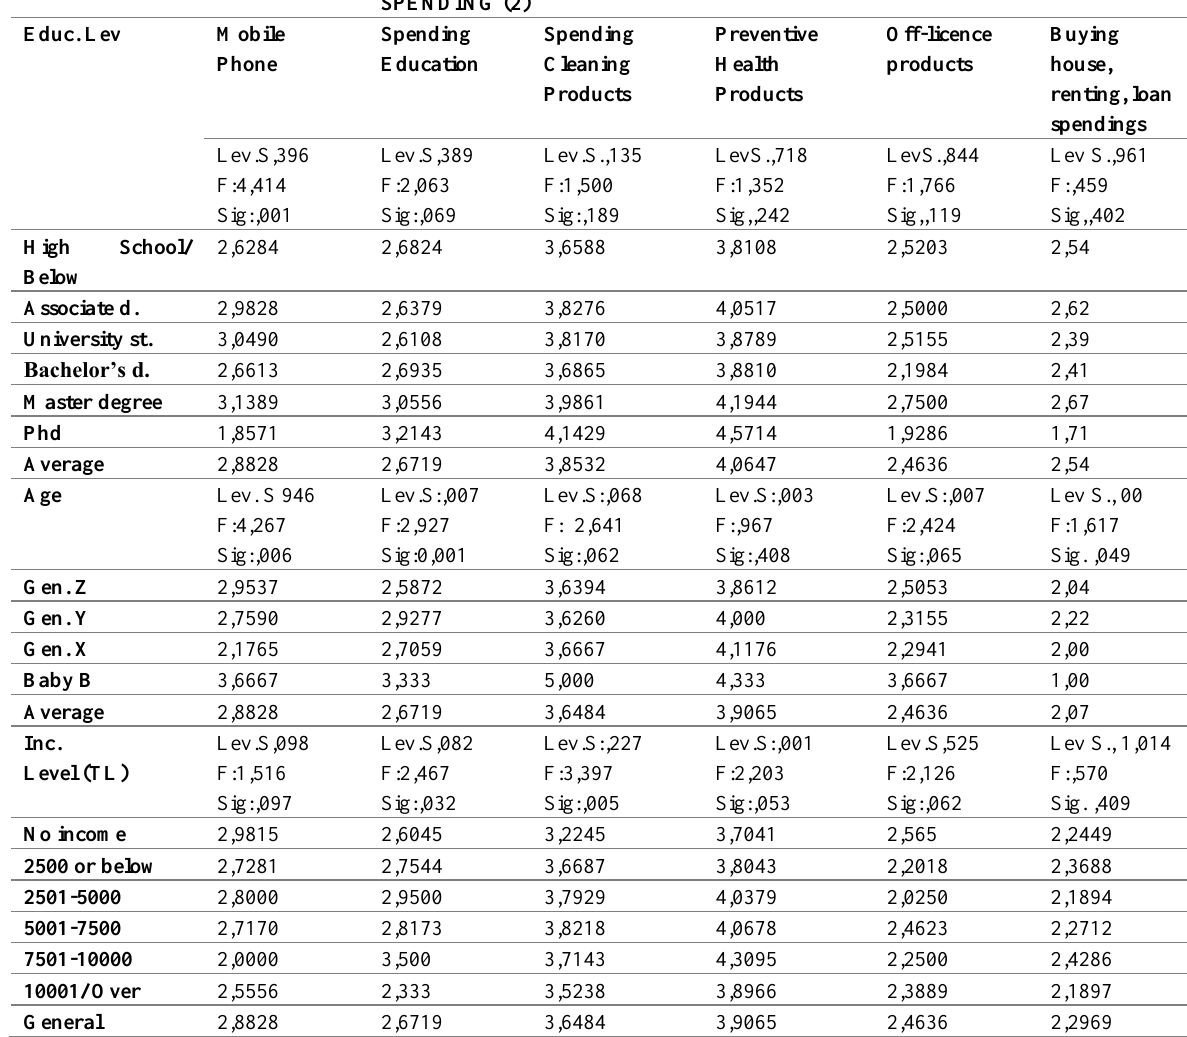
Table 5b: F Test (spending-2,